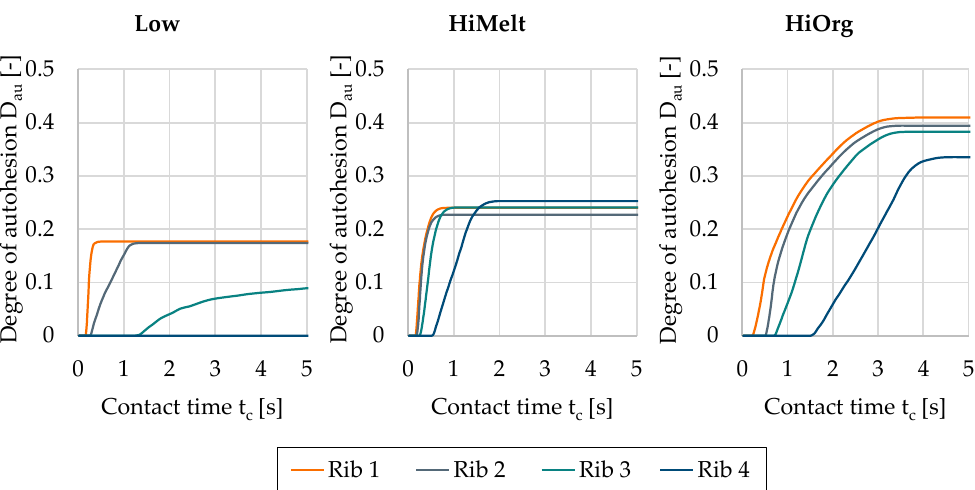
Figure 10. Degree of autohesion vs. contact time for the individual ribs depending on low process temperatures (“Low”), a high melt temperature “HiMelt”, and a high organo sheet temperature “HiOrg” (cf. Table 1).